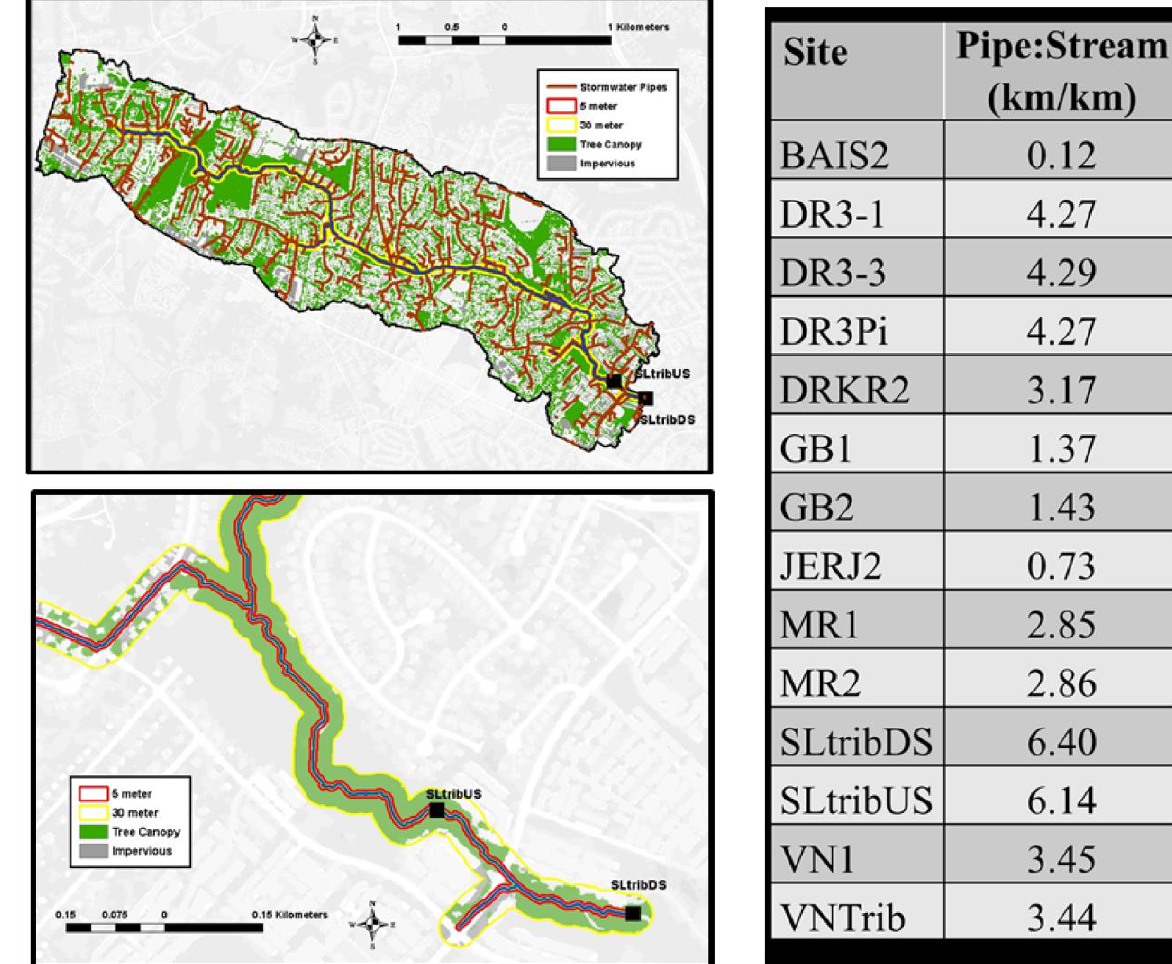
Figure 2. Loggershed pipe to stream ratio (km/km) for all sites and example of the SLtribDS site loggershed, showing the length of stormwater pipes and closeup of the tree canopy and impervious land cover within riparian areas (5 and 30 m).